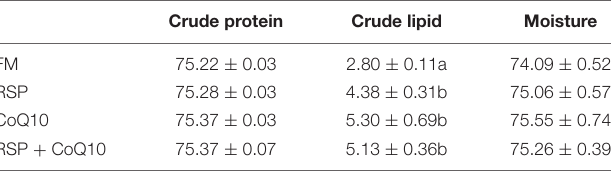
TABLE 3 | Muscle compositions (% dry weight) of L. vannamei fed four different